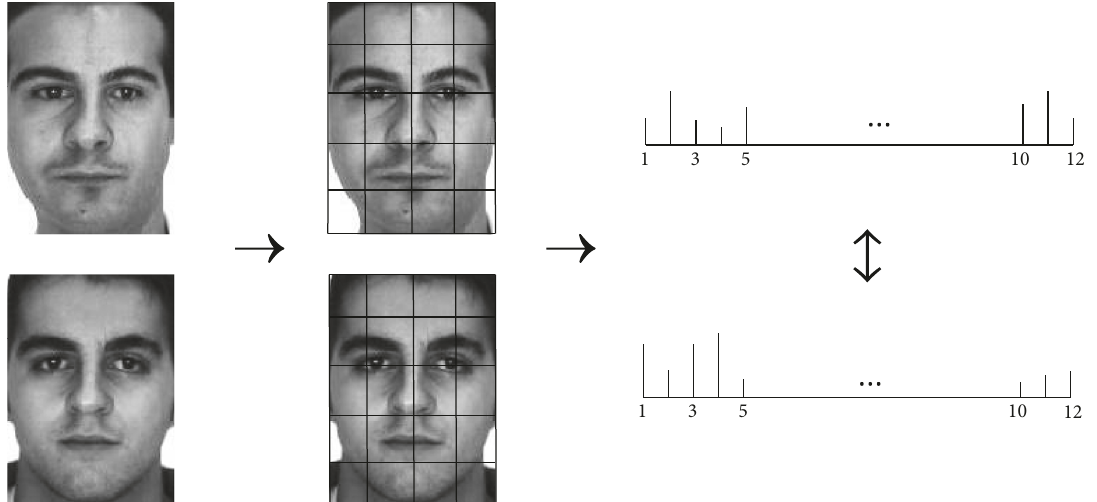
Figure 5: The leftmost one is the first image of the 1st and 10th persons in the AR database. The two AR face images are divided into 20 (5×4) blocks as shown in the middle column. The rightmost one reveals the two block histograms (in total 20 couples of histograms) between any two samples, which are used for calculating the dissimilarity (for Extended Yale B, face images are divided into 30 (6 × 5) blocks, including a total of 30 couples of histograms and the other settings are the